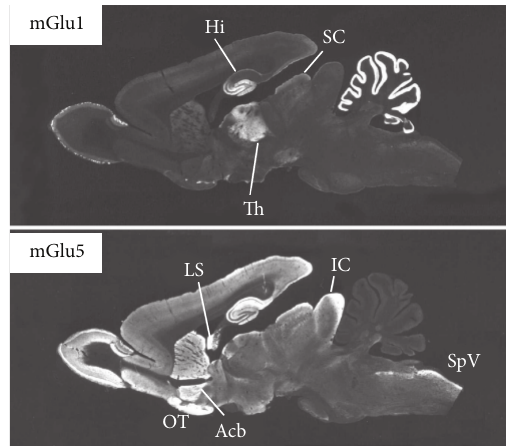
Figure 2: Immunolocalisation of mGlu 1 and 5 receptors within rat brain parasagittal sections. Acb, nucleus accumbens; Hi, hippocam- pus; IC, inferior colliculus; LS, lateral septal nucleus; OT, olfactory tubercle; SC, superior colliculus; SpV, spinal trigeminal nuclei; Th, thalamus